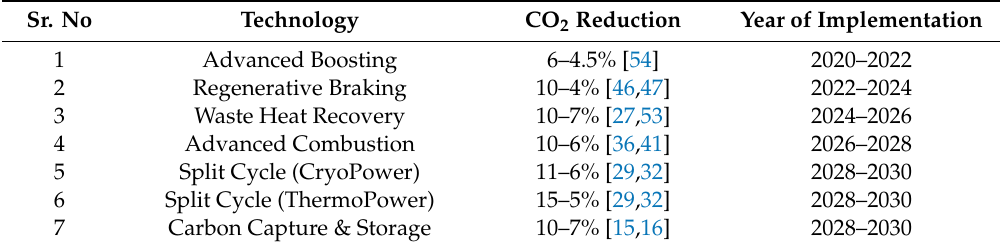
Table 3. CO 2 % Reduction of all the Technologies & its Implementation.